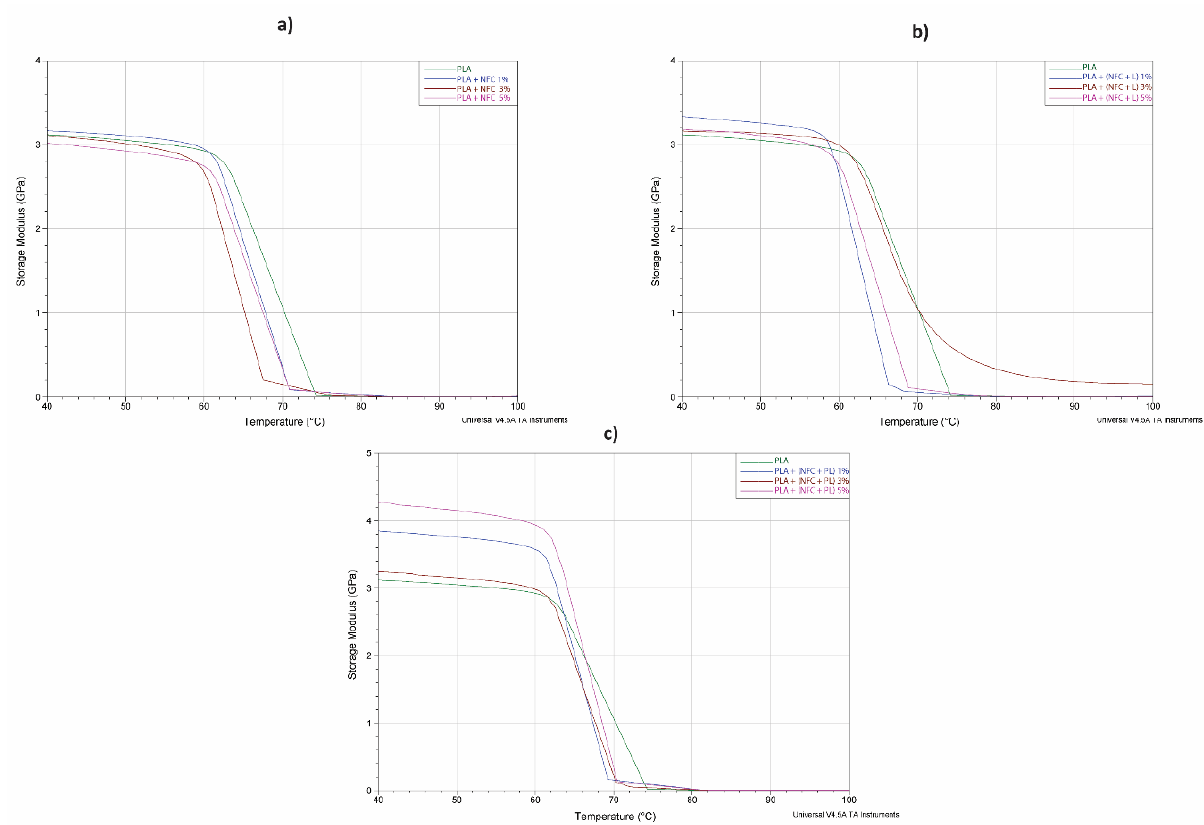
Figure 10. Bending storage modulus (E’) vs. temperature at 10 Hz of oscillation of filaments in groups ( a ) GR1, ( b ) GR2, and ( c ) GR3. Table 7. Bending storage modulus E’ at 40 °C and glass transition temperature T g of filaments.